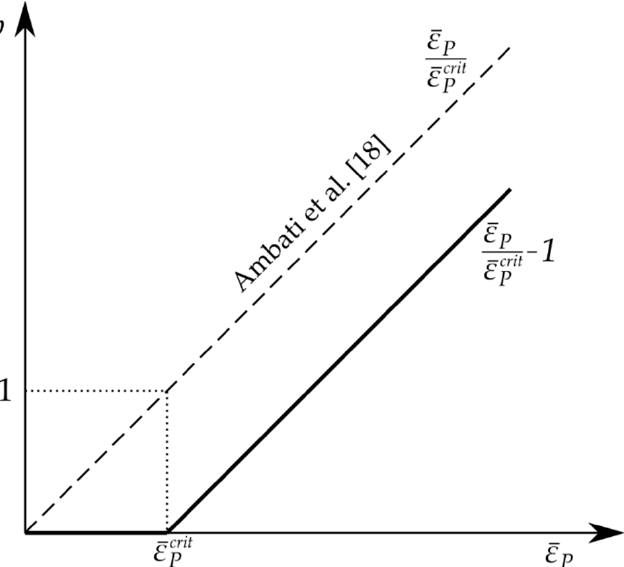
Figure 2. New coupling variable p (continuous line) in relation to the equivalent plastic strain ε P compared to Ambati et al. [18].